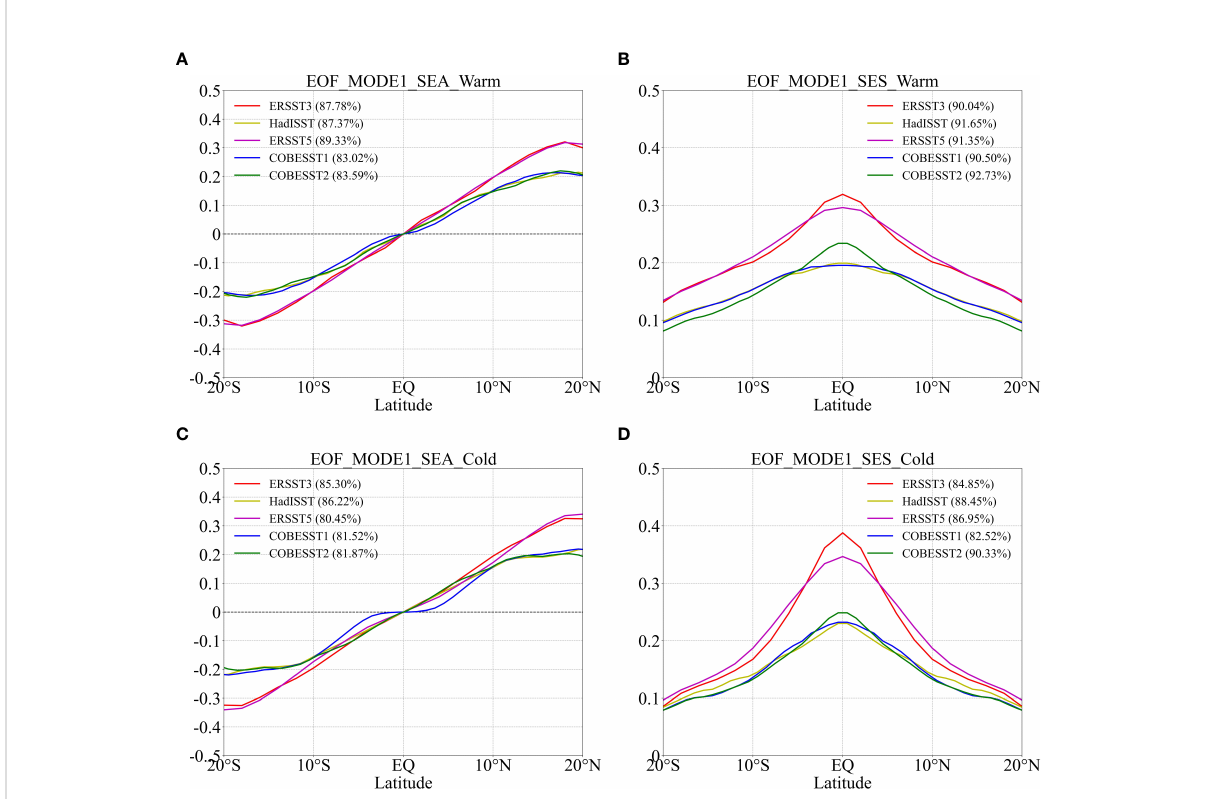
FIGURE 6 (A) The dominant principal mode of the SEA under IPWP warm events. (B) as in (A) but for the SES. (C, D) as in (A, B) respectively, but for the variation during IPWP cold events. The red, yellow, magenta, blue and green lines are based on the ERSST3, HadISST, ERSST5, COBESST1 and COBESST2 datasets,